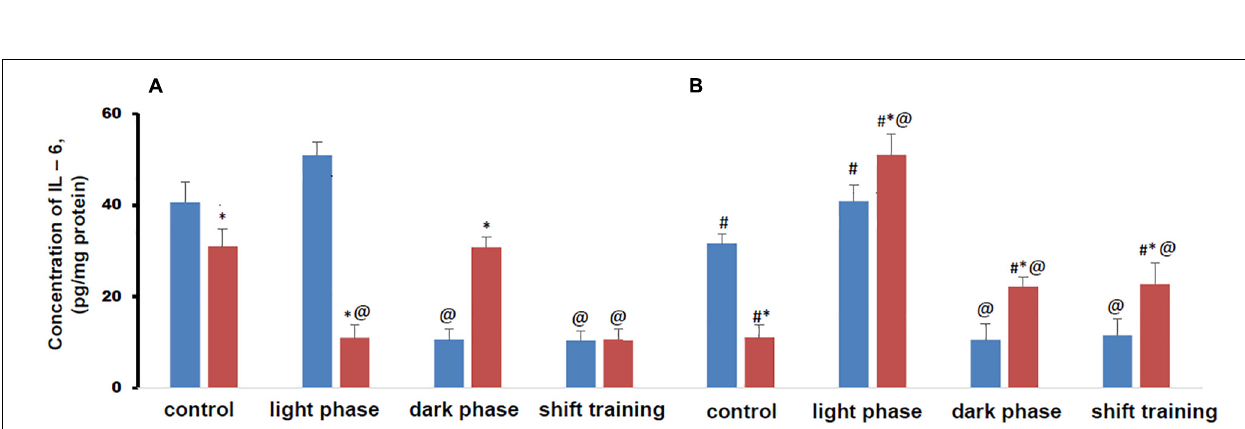
FIGURE 5 | Concentration of interleukin 6 (IL-6) in mice muscle tissue (pg/mg protein). Panel (A) shows young-age mice. Panel (B) shows old-age mice. Blue columns represent Chow diet and red columns represent High fat diet. Data are presented as the mean ± error of the mean. *Significantly different ( p < 0.05) from Chow diet. #Significantly different ( p < 0.05) from young-age mice. @Significantly different ( p < 0.05) from control.